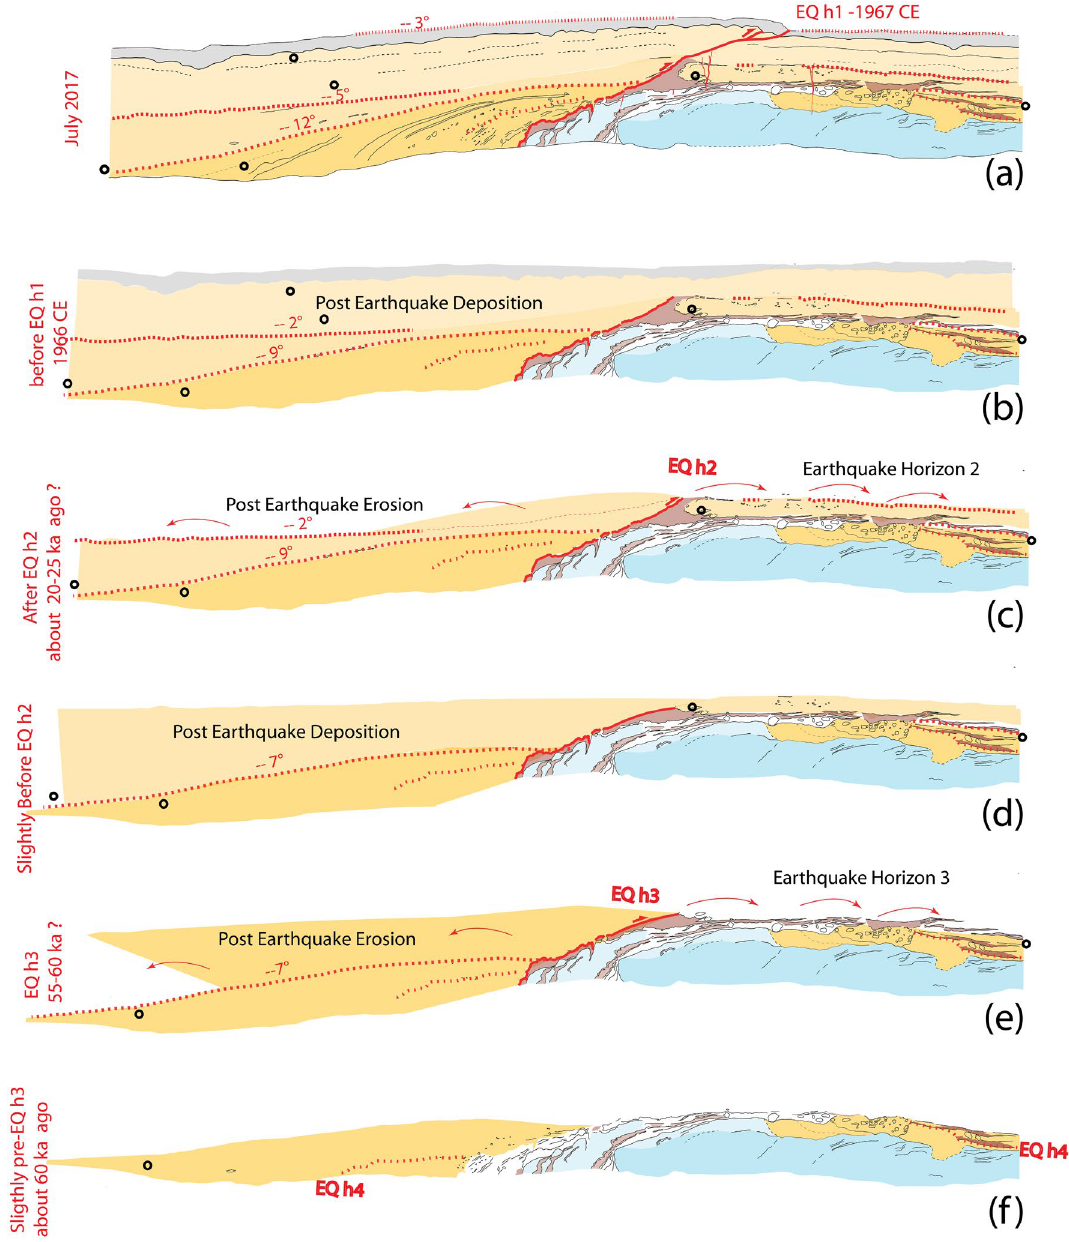
Figure 4. Schematic reconstruction. Incremental growth of the fold. Tilting of the frontal